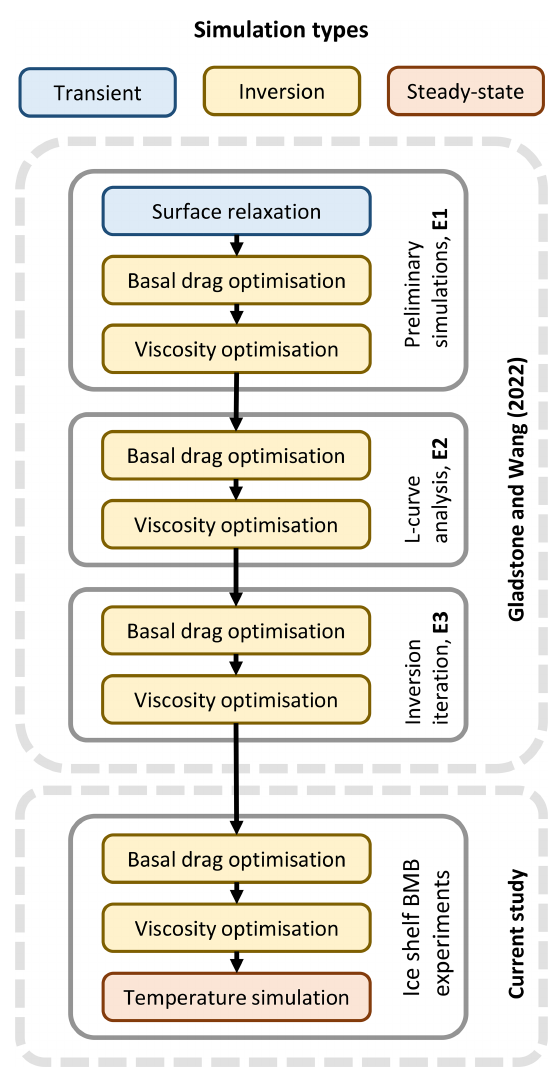
Figure 2. Overview of the 3-D simulation workflow in this study. Simulations are indicated in coloured boxes. Experiments are indi- cated in grey outlined boxes. Arrows indicate the use of the final model state from a simulation to initialise the following simulation. Experiment E1, E2 and E3 are from Gladstone and Wang (2022), while the ice shelf BMB experiments are carried out in the current